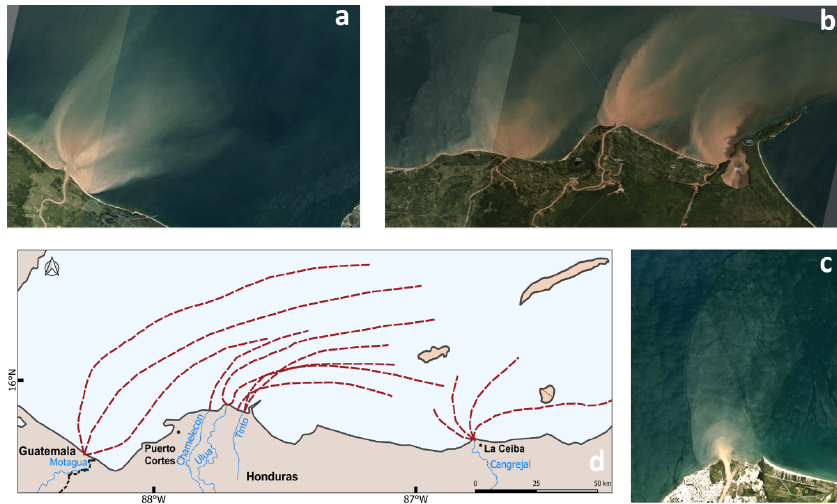
Figure 6. Plastic debris source, corresponding river discharges and estimated debris trajectories based on multitemporal satellite detections in the Bay Islands and Gulf of Honduras. ( a ) Motagua River discharges as recorded during the 27th of September 2017. ( b ) Detected discharges of Chamelecon, Ulua and Tinto rivers on the 27th of September 2017. ( c ) Detected Cangrejal River discharge on the 20th of September 2017. ( d ) Estimated litter travelling trajectories (red dashed lines) based on the multitemporal detections. Plastic pathways followed, in general, a SW–NE direction similar to currents direction acquired from Copernicus Marine Environment Monitoring Service (CMEMS).